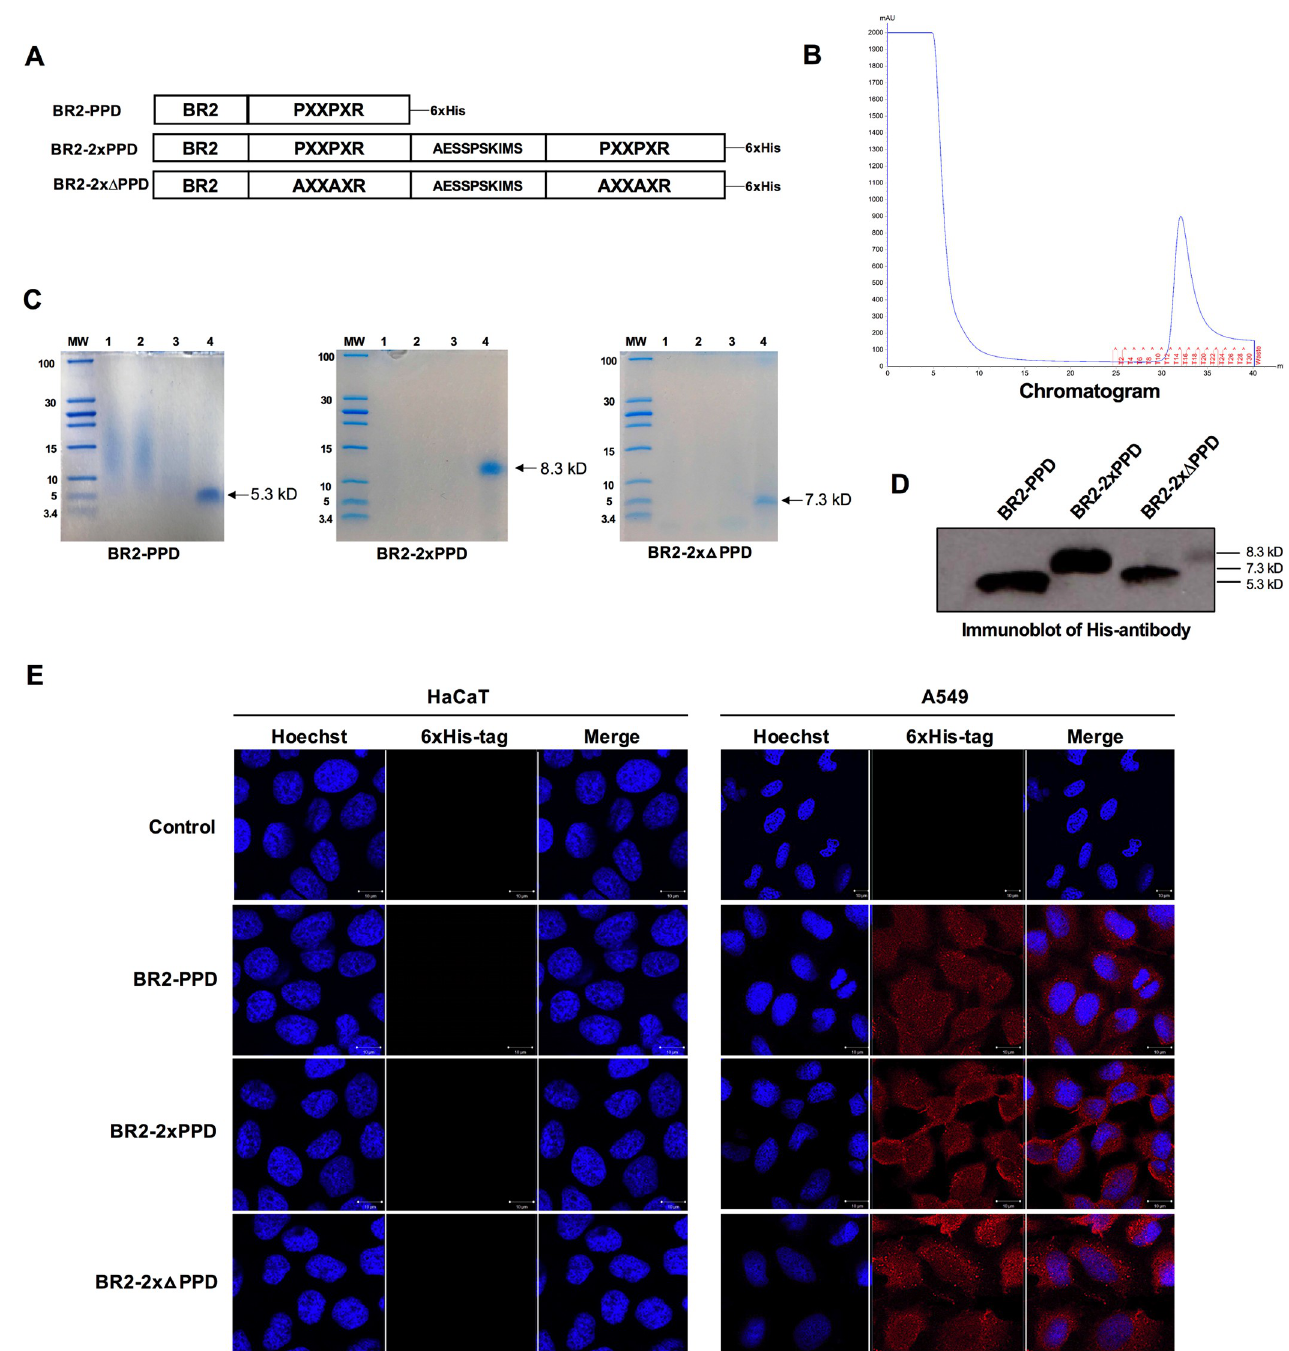
Fig 1. Characterization of the cancer-specific BR2 containing PR-PPD peptides. (A) A schematic of BR2 containing PR-PPD peptides. Polyproline domain (PPD) of human progesterone receptor (PR) was added to the C-terminal of the cell-penetrating peptide (CPP), Buforin2 (BR2). The nucleotide sequences were cloned into a pPICZ α A expression vector and transformed into Pichia pastoris KM71H by electroporation. All peptides were expressed as Histidine- tagged peptide and purified using a nickel column (B). His-tagged peptides were separated by SDS-PAGE followed by Coomassie blue staining (C) and immunoblotting (D). (E) A549 NSCLC cells and normal HaCaT keratinocyte cells were incubated with His-tagged peptides (2.5 μ M) for 1 h at 37˚C and stained with a 6-His specific monoclonal antibody. Intracellular localization of His-tagged peptides was visualized by confocal microscopy.